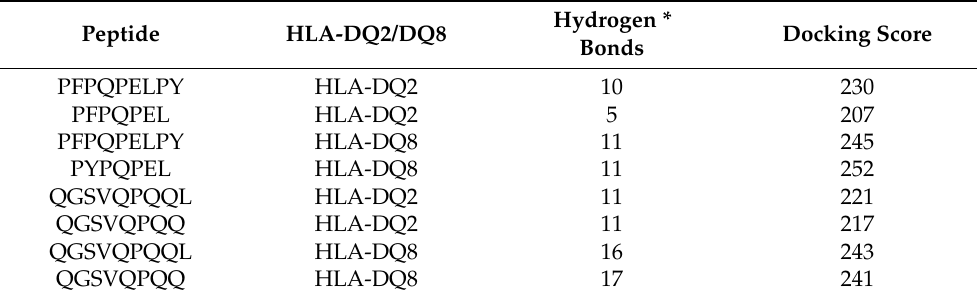
Table 1. Hydrogen bonds and docking score values calculated for the DQ2-specific peptide PF- PQPELPY and its truncated form PFPQPEL and the DQ8-specific peptide QGSVQPQQL and its truncated form QGSVQPQQ upon docking to the basket of HLA-DQ2 (PDB code 1S9V) and HLA- DQ8 (PDB code 4GG6). Peptide HLA-DQ2/DQ8